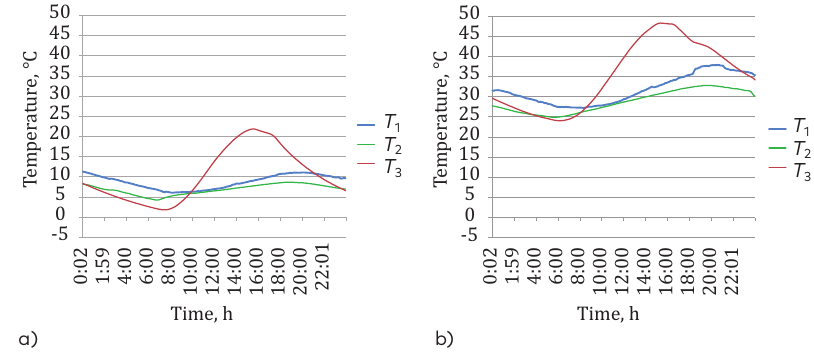
a) b) Figure 6. Daily temperature graph of the top slab ( T 3 ), bottom slab ( T 2 ) and air inside the girder ( T 1 ); a) 1 April 2019, b) 26 June 2019